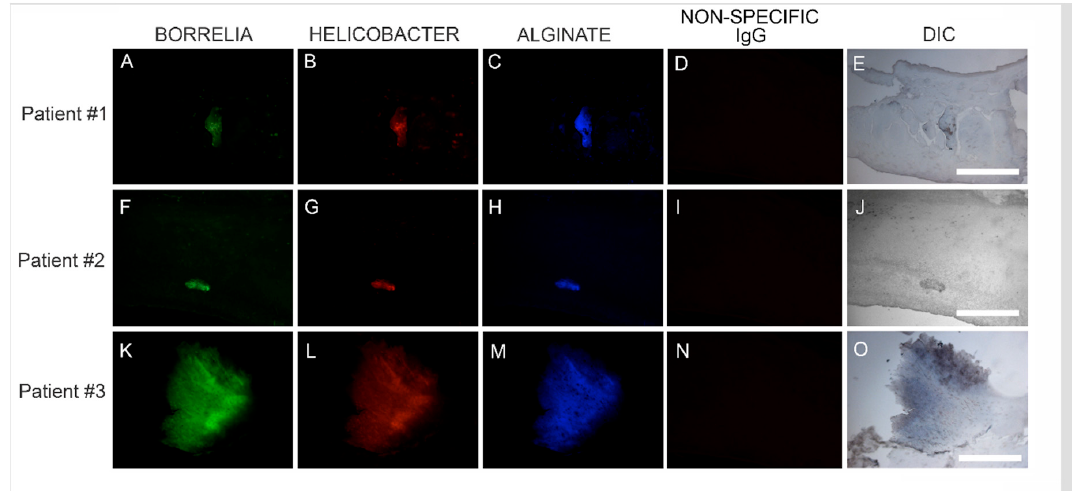
Figure 3. Representative IHC images showing Borrelia - and alginate-positive aggregates in MD skin sections from three subjects. IHC detection was performed as described in the Methods section. Panels A, E, I and M show skin sections treated with anti- Borrelia monoclonal antibody (green). Panels B, F, J and N show skin sections treated with anti-alginate antibody (red). Panels C, G, K and O show control skin sections treated with non-specific IgG. Panels D, H, L and P show sections imaged with DIC. All images were taken at 200× magnification. Scale bar = 100 µm.